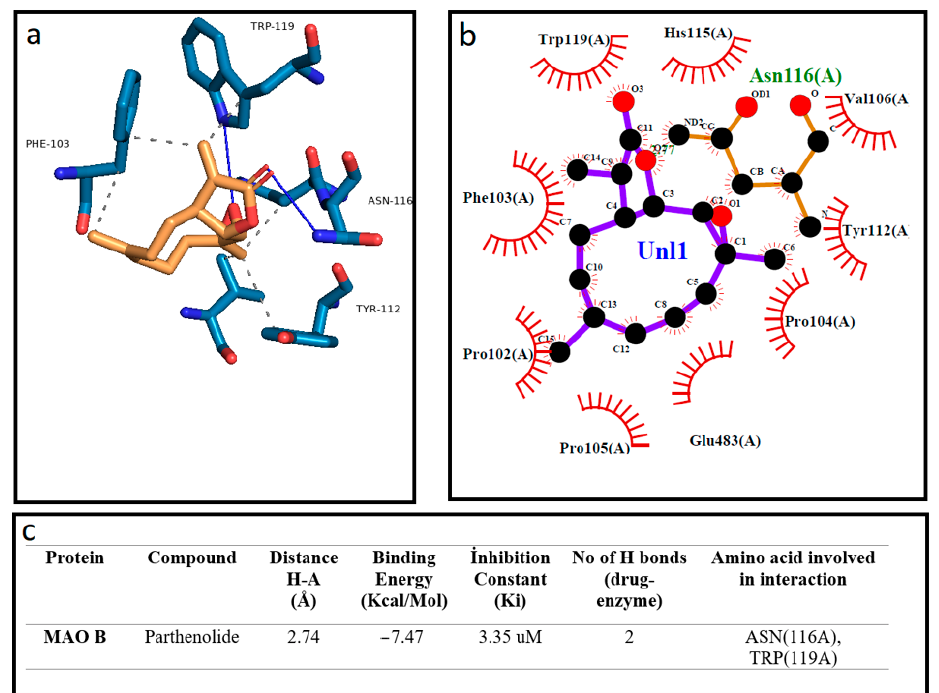
Figure 2. The best docking formation of the binding mode of Human Monoamine Oxidase B (Mao B-2BK5) with parthenolide obtained by ( a )—PyMol, ( b )—LigPlot, and ( c )—the table of Hydrogen- bonds (H-bonds) (with distance Å), binding energy (Kcal/mol), inhibition constant, number of H-bonds (drug-enzyme) and amino acid involved in interaction obtained from the Protein-Ligand Interaction Profiler. The blue line and dashed gray show the H-bonds and Hydrophobic Interaction in Pymol,